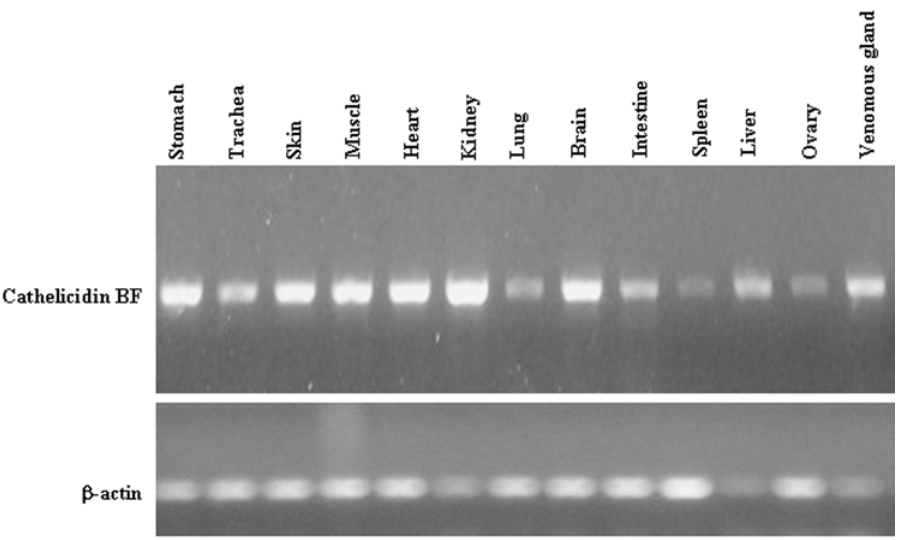
Figure 4. RT-PCR analysis of cathelicidin gene expression pattern in various snake tissues using gene-specific primers with actin as a control.